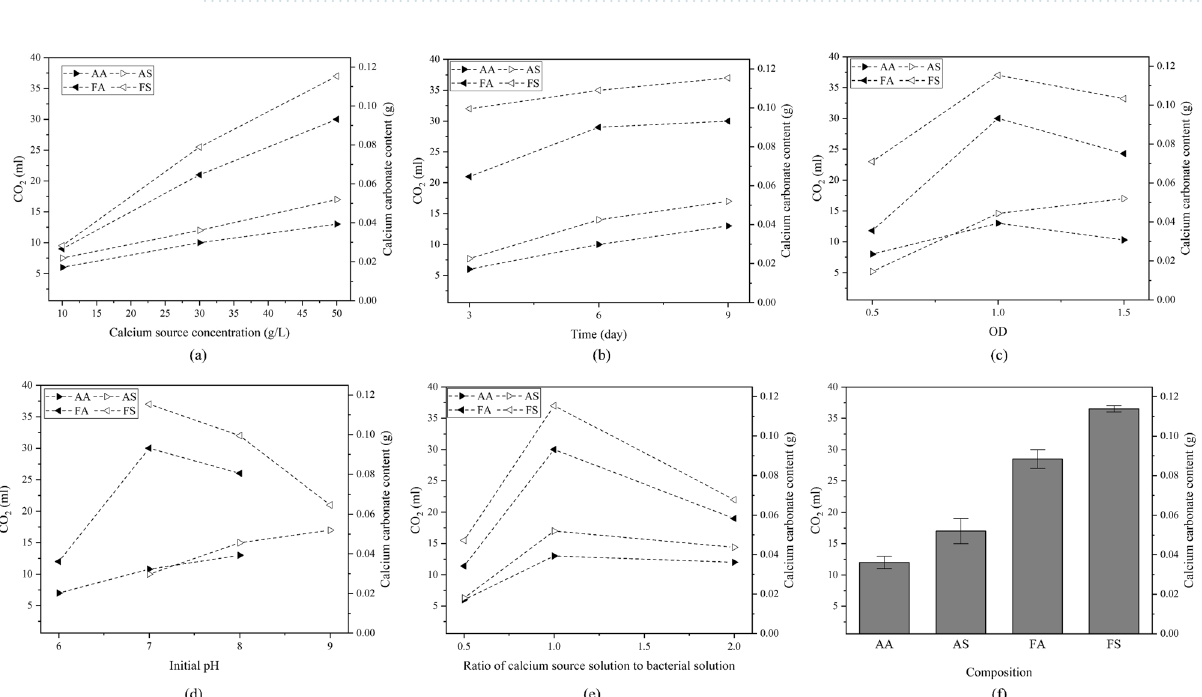
Figure 6. The variation of CO 2 volume measured in Bernard calcimeter (as well as corresponding CaCO 3 content) with ( a ) calcium source concentration, ( b ) curing time, ( c ) OD, ( d ) initial pH, ( e ) ratio of calcium source to bacterial solution, for each composition; and ( f ) maximum amount of calcium carbonate produced for each calcium source-bacteria